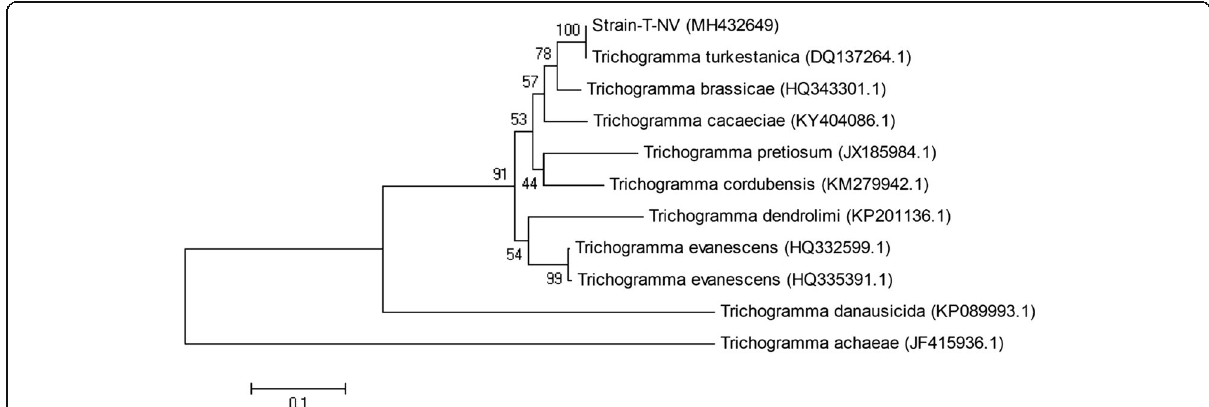
Fig. 11 Phylogenetic analysis of ITS2 region of rDNA of TNV and other related Trichogramma spp . by neighbor-joining method. In the phylogenetic tree, TNV and Trichogramma turkestanica clustered together as one clade. The scale bar indicates 0.1 nucleotide substitutions per nucleotide position. Numbers at the nodes indicate bootstrap support (%) based on 1000 replicates. GenBank accession numbers given in parentheses